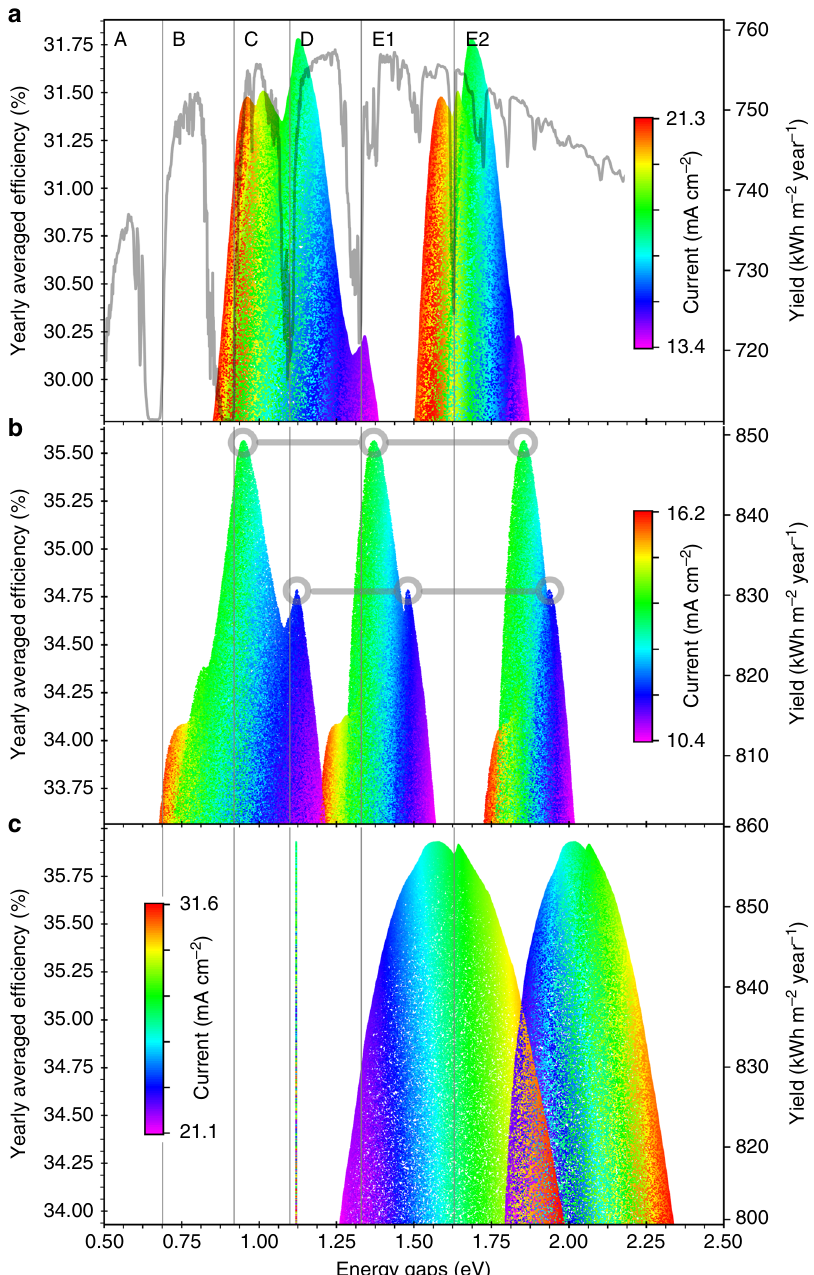
Fig. 4 Energy yields at 1 sun. Labels on top correspond to the low energy thresholds of each of the atmospheric transmission bands. a Two junctions. The standard global spectral irradiance is overlaid to highlight the alignment of the optimal band gaps with the transmission bands in the spectrum. b Three junctions. Two sets of near optimal band gaps are highlighted to illustrate that points with the same ef fi ciency value and the same color (average photocurrent) are junctions belonging in the same tandem device. c Three junctions with a mechanically stacked and electrically isolated monofacial silicon bottom